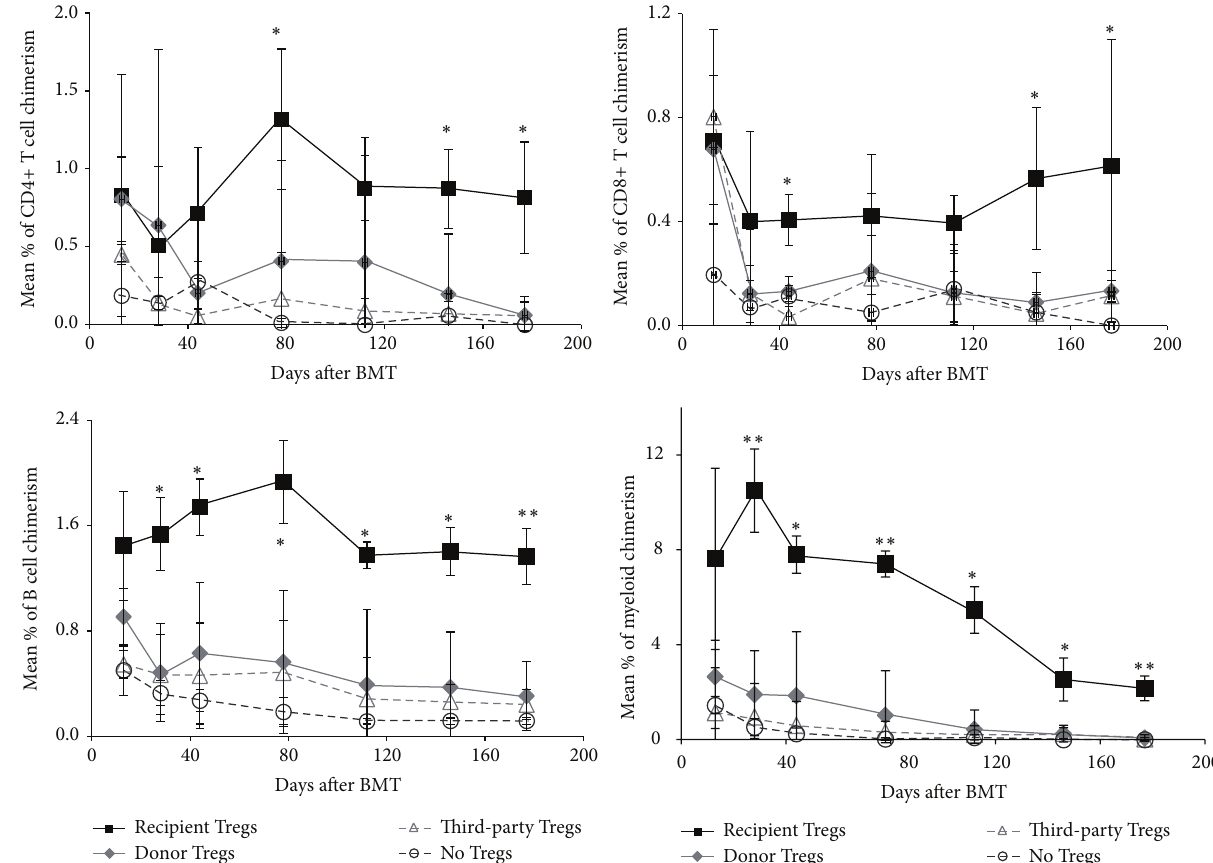
Figure 4: Recipient but not donor and third-party Tregs prevent BM rejection. Groups of B6 mice were grafted with 15–20 × 10 6 Balb/c BM cells under the cover of costimulation blockade (anti-CD154, CTLA4Ig) and rapamycin ( I no Tregs; control 𝑛 = 5 ) and were additionally treated with 3 × 10 6 nTregs of recipient ( ◼ 𝑛 = 4 ), donor ( X 𝑛 = 4 ), or third-party ( 󳵻 𝑛 = 3 ) origin. Donor (H-2D d + ) chimerism among leukocytes of T cell (CD4 + and CD8 + ), B cell (B220 + ), and the myeloid (Mac1 + ) lineage was assessed by flow cytometry of peripheral blood at multiple time points and is shown as mean percent (error bars indicate standard deviation). ∗∗ 𝑝 < 0.005 , ∗ 𝑝 < 0.05 (Student’s 𝑡 -test for recipient Tregs versus each other